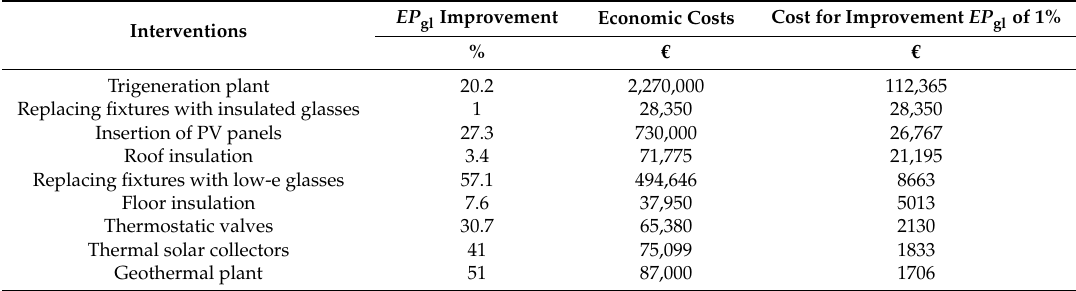
Table 15. Economic costs and EP gl percentage improvement for each considered